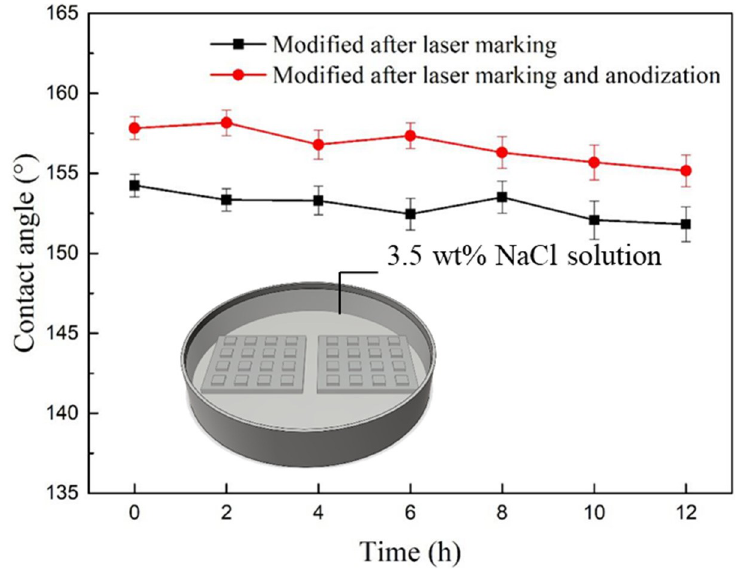
Figure 7. The WCA on the superhydrophobic surfaces after immersing in 3.5 wt% NaCl solution recorded every 2 h.